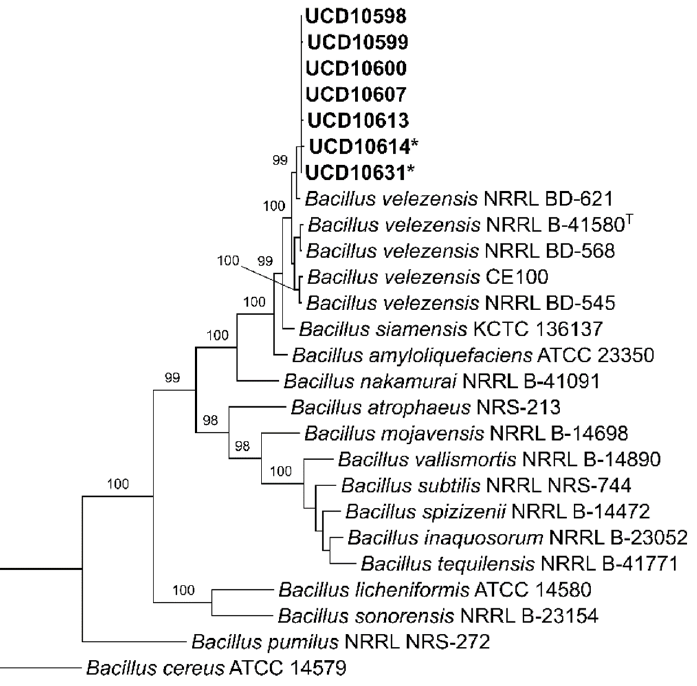
Figure 2. Most parsimonious phylogenetic analysis of seven isolates of Bacillus velezensis recovered from commercially grown various grapevine cultivars in California compared to closely related strains and species. The tree was inferred from a six-locus data set (16S rDNA- gyrA - rpoB - purH -polC- groEL ). Numbers above branches represent non-parametric bootstrap values from 1000 replicates. B. cereus (ATCC 14579) was used as outgroup. T = type strain of B. velezensis (NRRL B-41580 = CR-502). * = isolates used in dual antagonism assays and metabolites